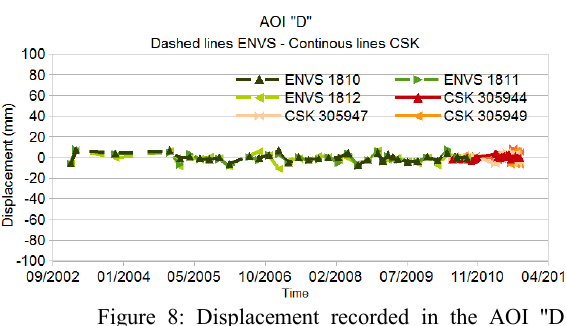
Figure 8: Displacement recorded in the AOI "D" using Cosmo-SkyMed and Envisat satellites